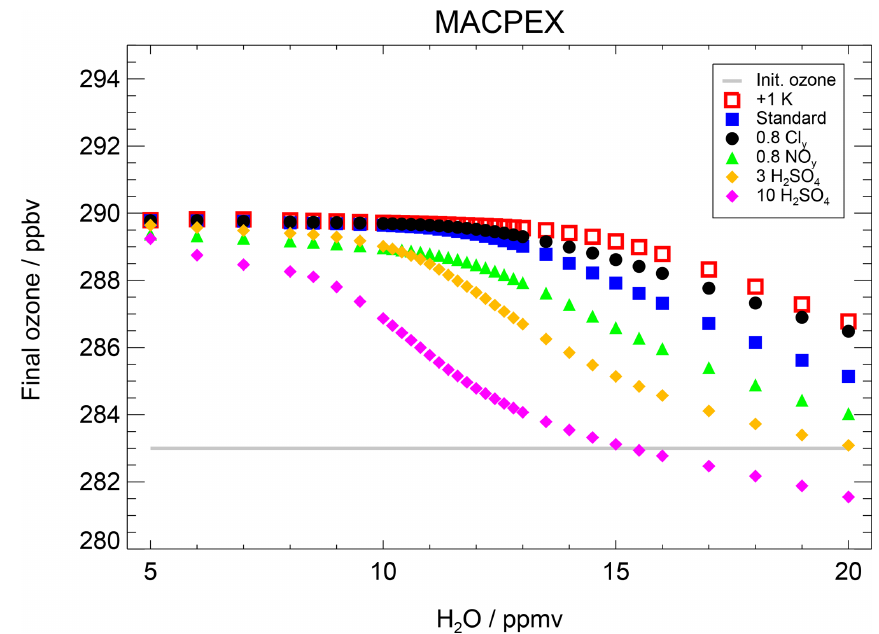
Figure B2. Impact of the water vapour content on the ozone mixing ratio (final ozone) reached at the end of the 7d simulation along the MACPEX trajectory. The standard case is shown in blue and the initial ozone amount is marked by the grey line. An impact on the final ozone mixing ratios is observable after exceeding a critical threshold in water vapour. This threshold changes with a shift in the temperature ( + 1K, red), the Cl y mixing ratio to 0.8 Cl y (black), the NO y mixing ratio (0.8 NO y , green) and the sulfate content (3 × standard H 2 SO 4 , yellow, 10 × standard H 2 SO 4 ,